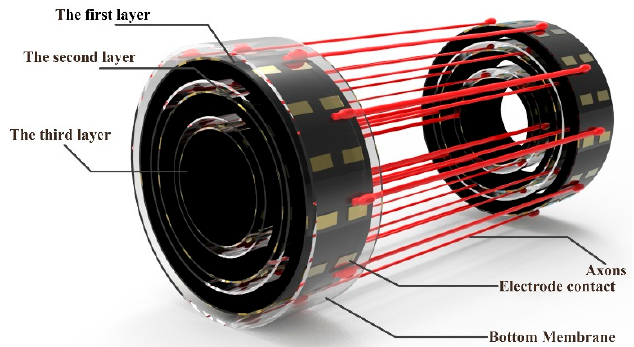
Figure 10. Design of a multi-layer three-dimensional nerve traction culture